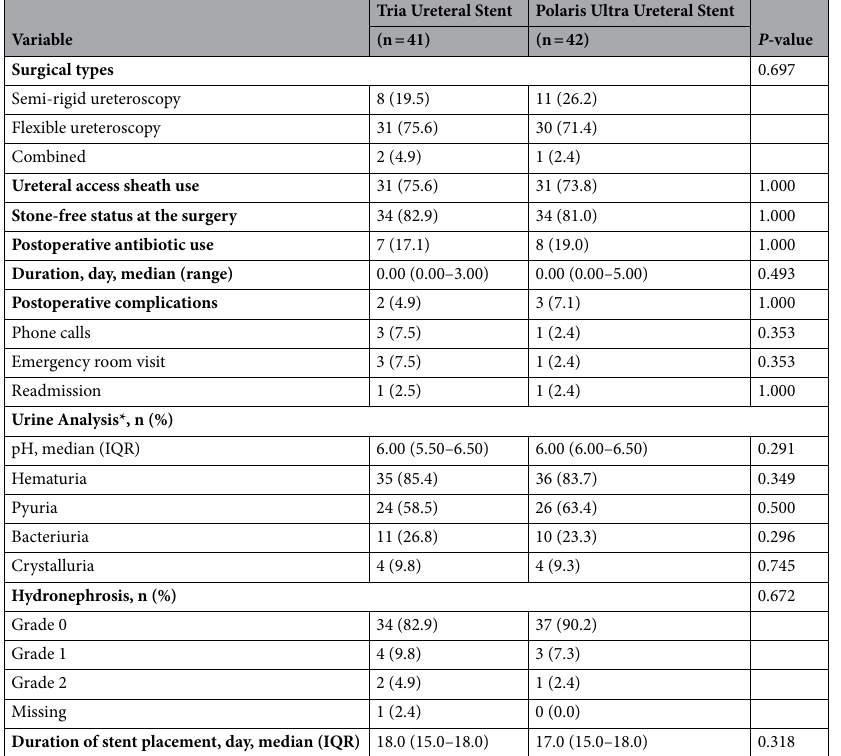
Table 2. Intra- and postoperative clinical data. IQR interquartile range. Chi-square test and Wilcoxon test were used for statistical analysis. *Six patients (Tria: n = 2, and Ultra: n = 4) were missing.